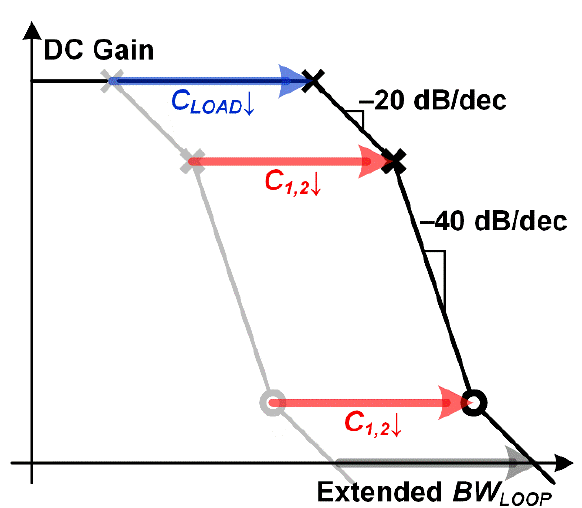
Figure 5. Bode plot of loop in the voltage-mode boost converter.